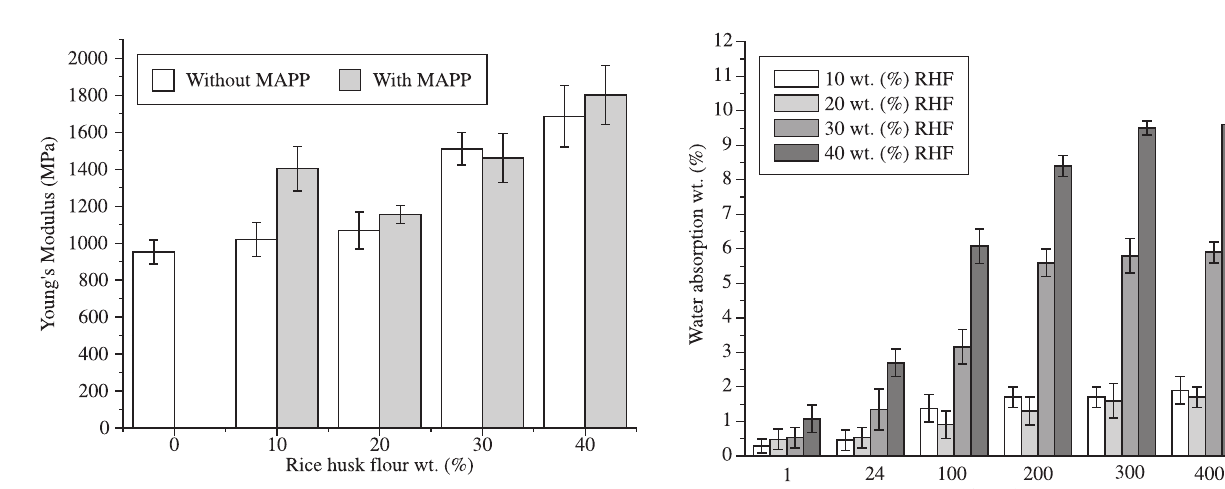
Figure 1. Effect of RHF and MAPP on tensile strength.